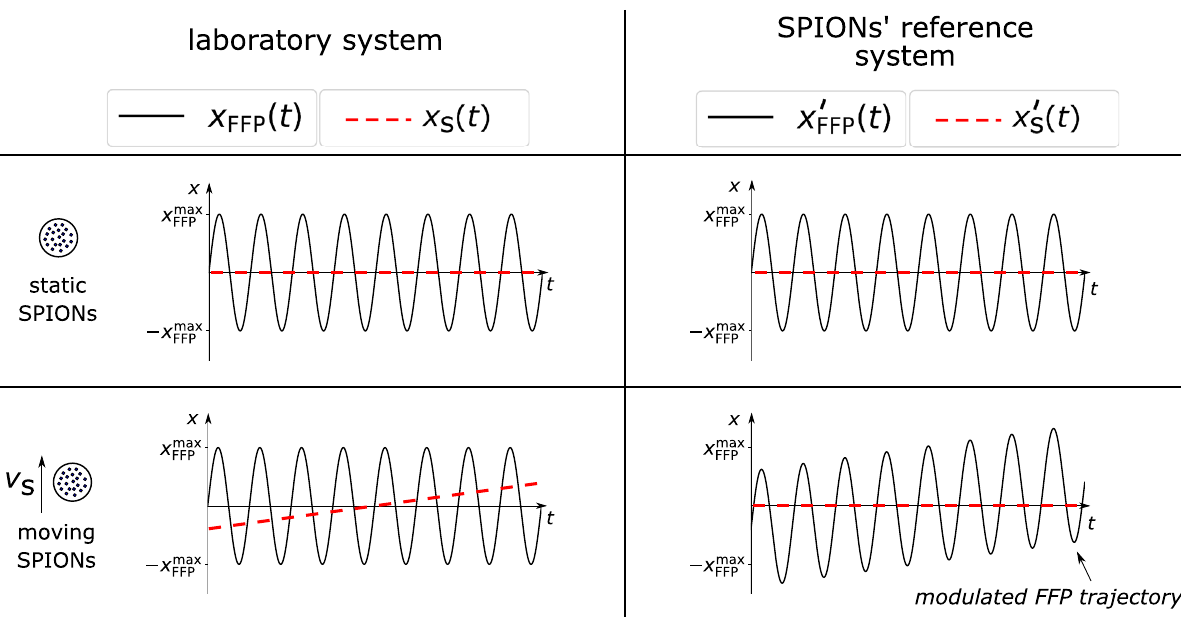
Figure 2. Field free point (FFP) trajectory modulation. Temporal progress of FFP and SPION position in laboratory system ( x FFP ( t ) , x s ( t ) ) and reference frame of the nanoparticles ( x ′ FFP ( t ) , x ′ s ( t ) ) for static and moving SPIONs. The modulation of the FFP trajectory in the SPIONs’ reference system x ′ FFP ( t ) = x FFP ( t ) + v s t is caused by the particles’ motion in the laboratory